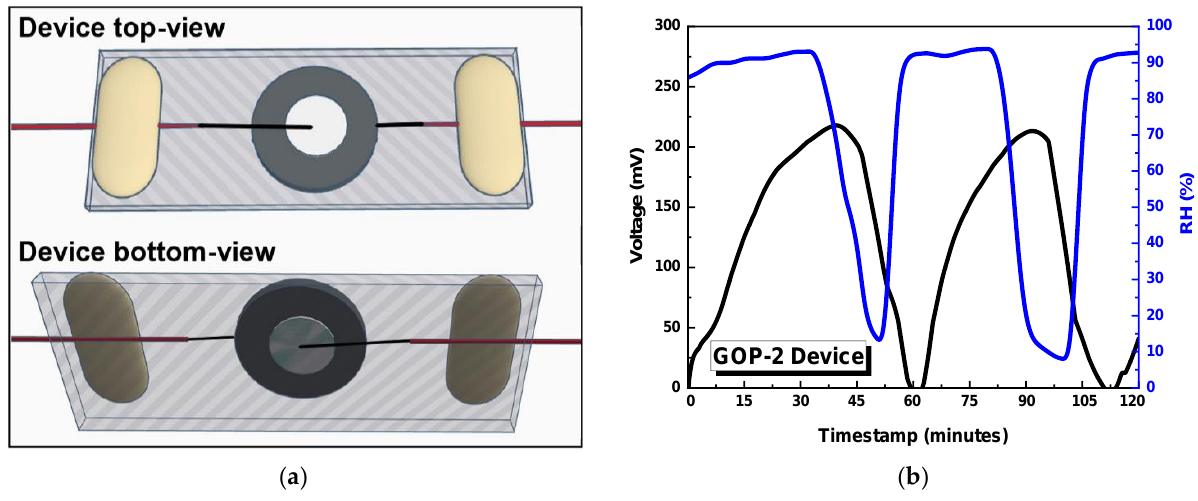
Figure 5. ( a ) Schematic representation of MEG device constructed using a GOP-2 as the moisture absorbing material and large sur-face-area contacts in a vertical configuration; ( b ) Moisture-induced voltage (V o ) generated by GOP-2 device as a function of RH (%). MEGs using GOF samples were also fabricated using broad silver contacts with a horizontal configuration, which is depicted along with a typical V o response in Figure 6.